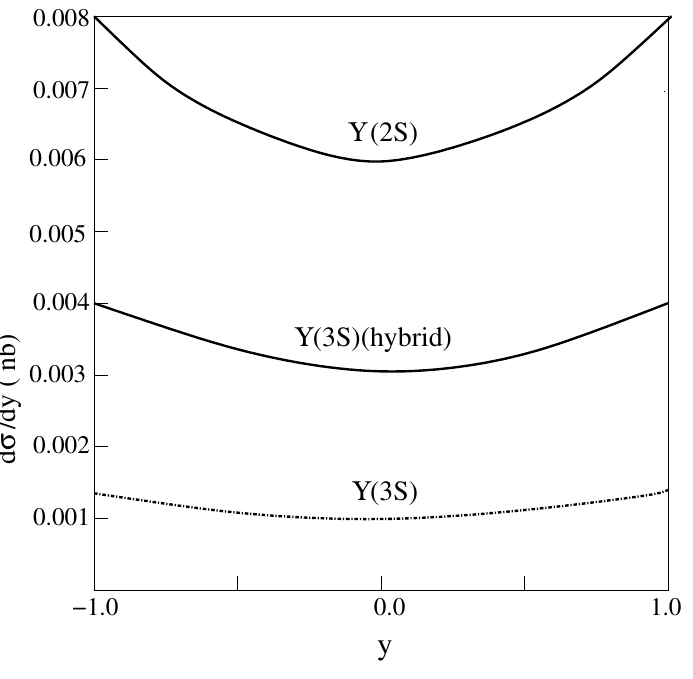
Figure 3 . d (cid:27) /dy for 2m=10 GeV,